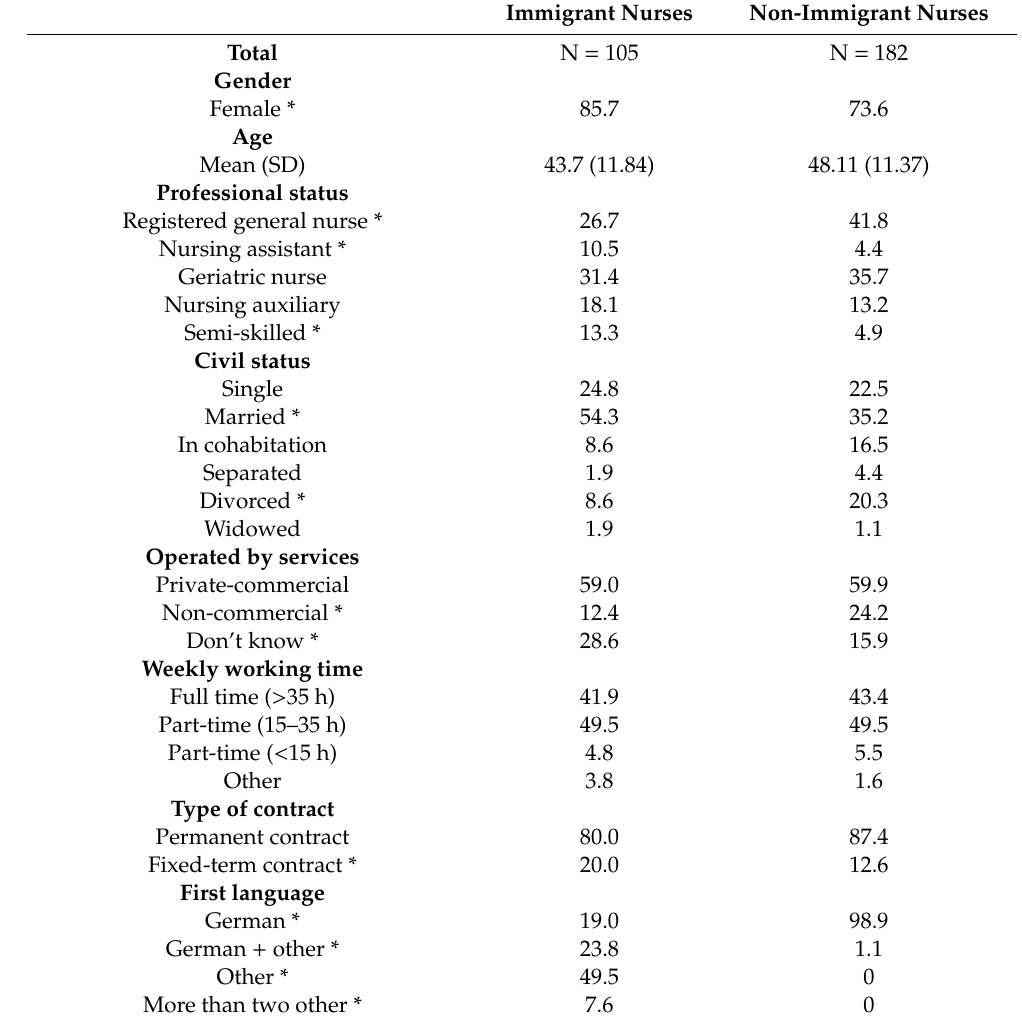
Table 1. Sociodemographic data of the total sample. Immigrant